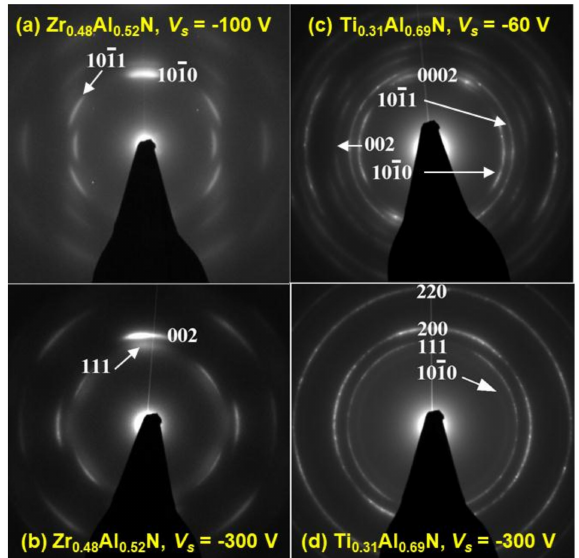
Figure 4. Selected area electron diffraction patterns for: Zr 0.48 Al 0.52 N ( a ) V s = − 100 V and ( b ) V s = − 300 V; and for Ti − 60 V and ( d ) V s = − 300 V 0.31 Al 0.69 N ( c ) V s =